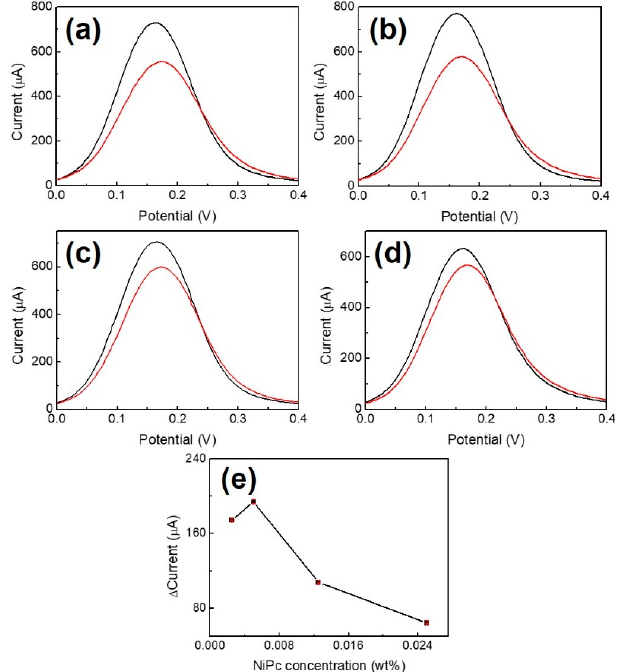
Figure 4. Differential pulse voltammetry (DPV) analysis for the preparation of Au/NiPc electrodes at different NiPc/THF concentrations. ( a ) 2.5 × 10 − 3 wt%, ( b ) 5.0 × 10 − 3 wt%, ( c ) 12.5 × 10 − 3 wt%, and ( d ) 25 × 10 − 3 wt%. The black and red curves represent the results of the Au and Au/NiPc electrode measurements, respectively. ( e ) Peak current change versus concentration of NiPc/THF ( n = 3).